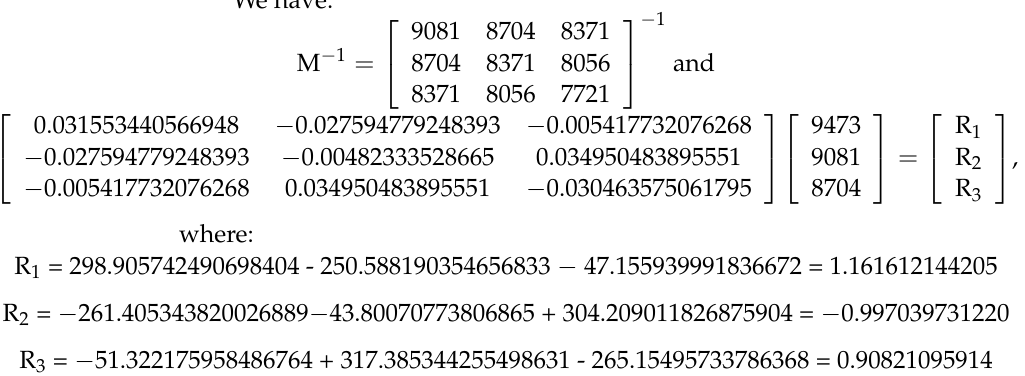
Figure 5. Top : estimation of the effective reproduction number R e ’s for 30 September and the 5 October 2020 (in green, with Figure 5 their 95% confidence interval) [28,29]. Bottom left : Daily new cases in Russia between 15 February and 21 November [30]. Bottom right : U-shape of the evolution of the daily R j ’s along the 3-day contagiousness